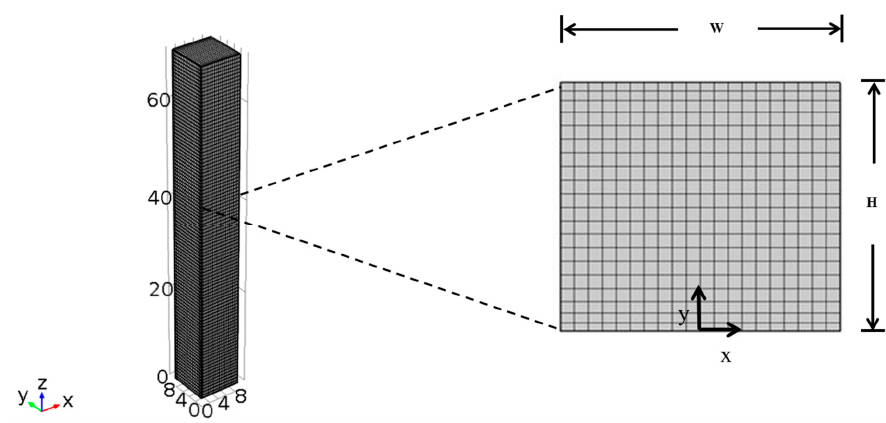
Figure 1. Schematic of the frying process; side view of the strip. H is the height of the strip sample; W is the width of the strip sample; and x and y are the coordinates.